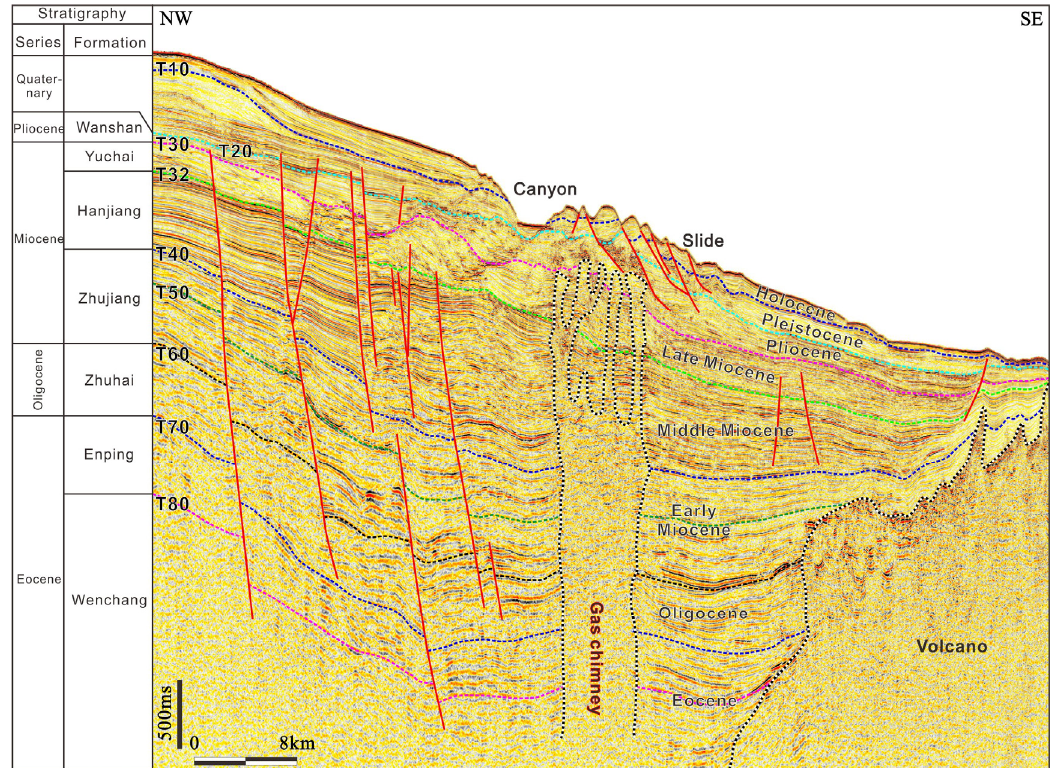
Figure 2. Framework of sequence stratigraphy and typical seismic profile of the Pearl River Mouth Basin.